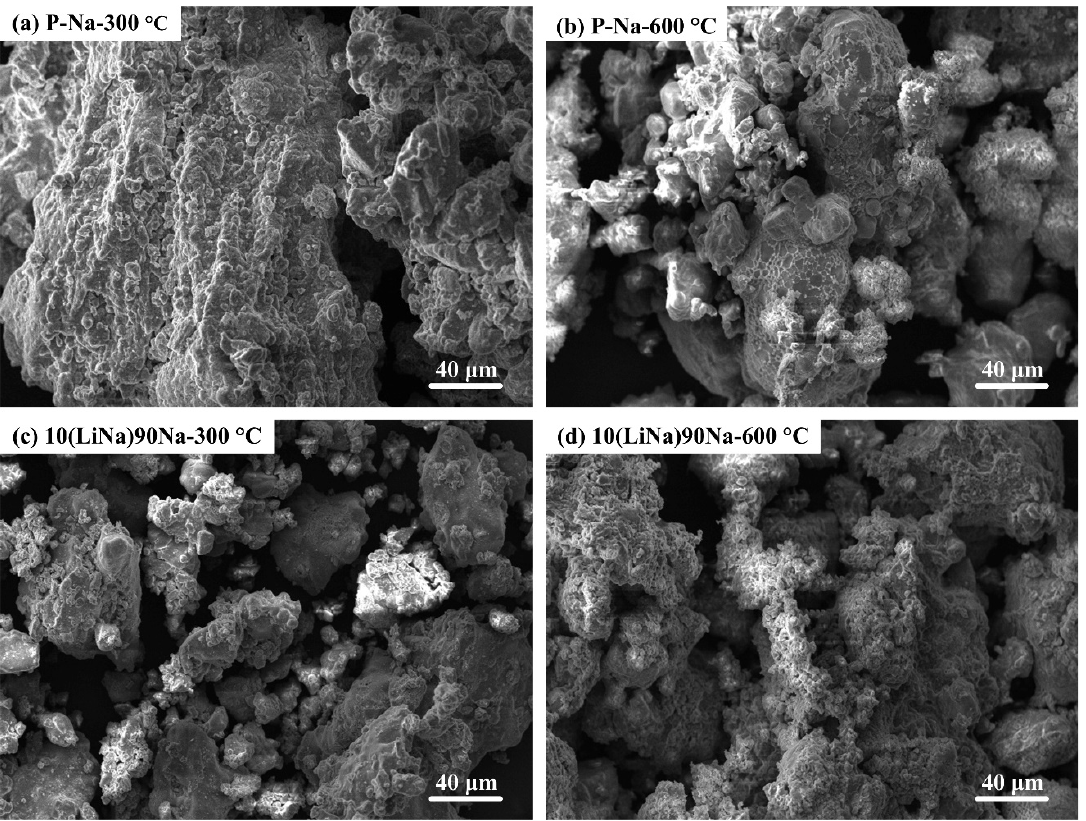
Figure 7. SEM images of P–Na and 10(LiNa)90Na after isothermal sorption at 300 °C and 600 °C. The CO 2 capture capacities of Na 4 SiO 4 phasically doped with different alkali